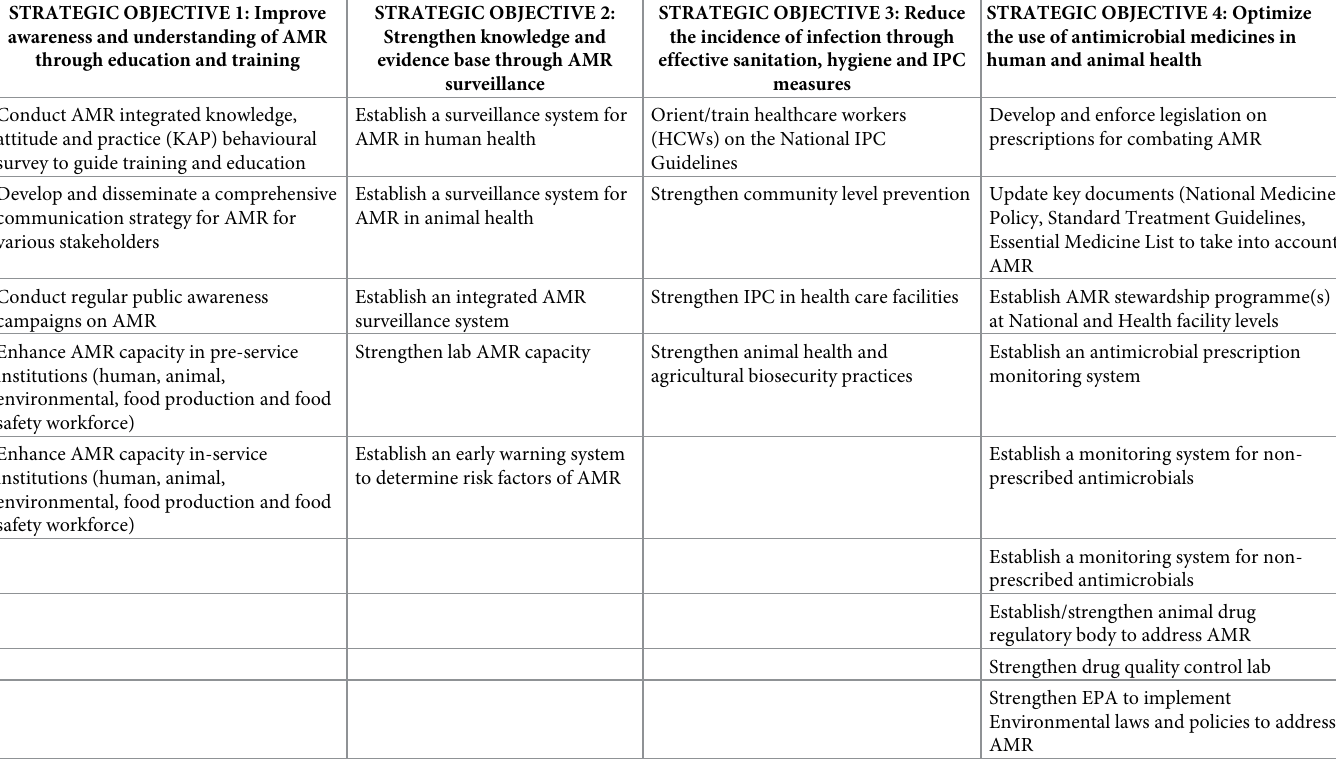
Table 1. List of potential interventions that countries carry out as guided by the global action plan strategic